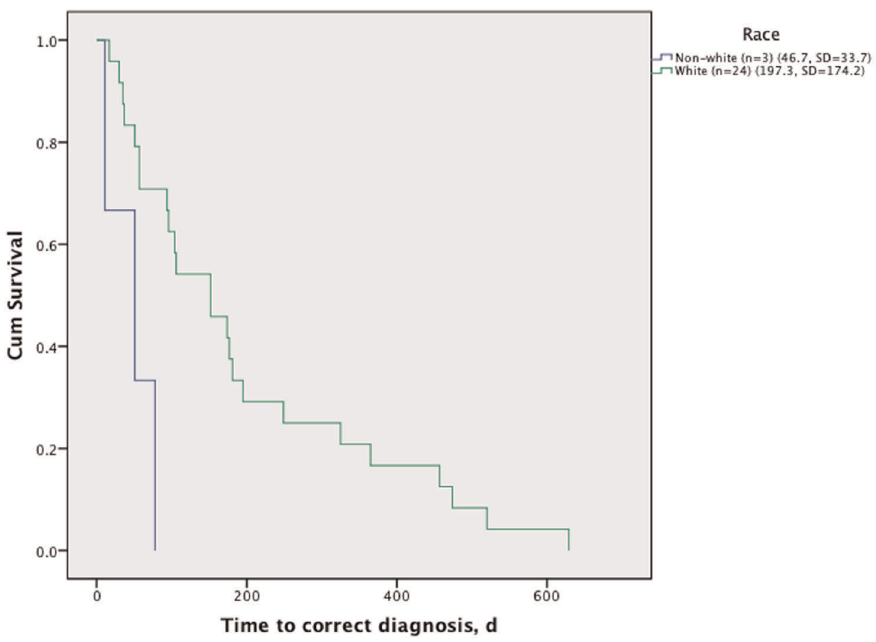
Figure 1. Time to correct diagnosis of sporadic Creutzfeldt-Jakob disease subjects by race/ethnicity. White race includes non-Hispanic and Hispanic Whites (Mantel-Cox, chi-square =7.1, p=0.008).